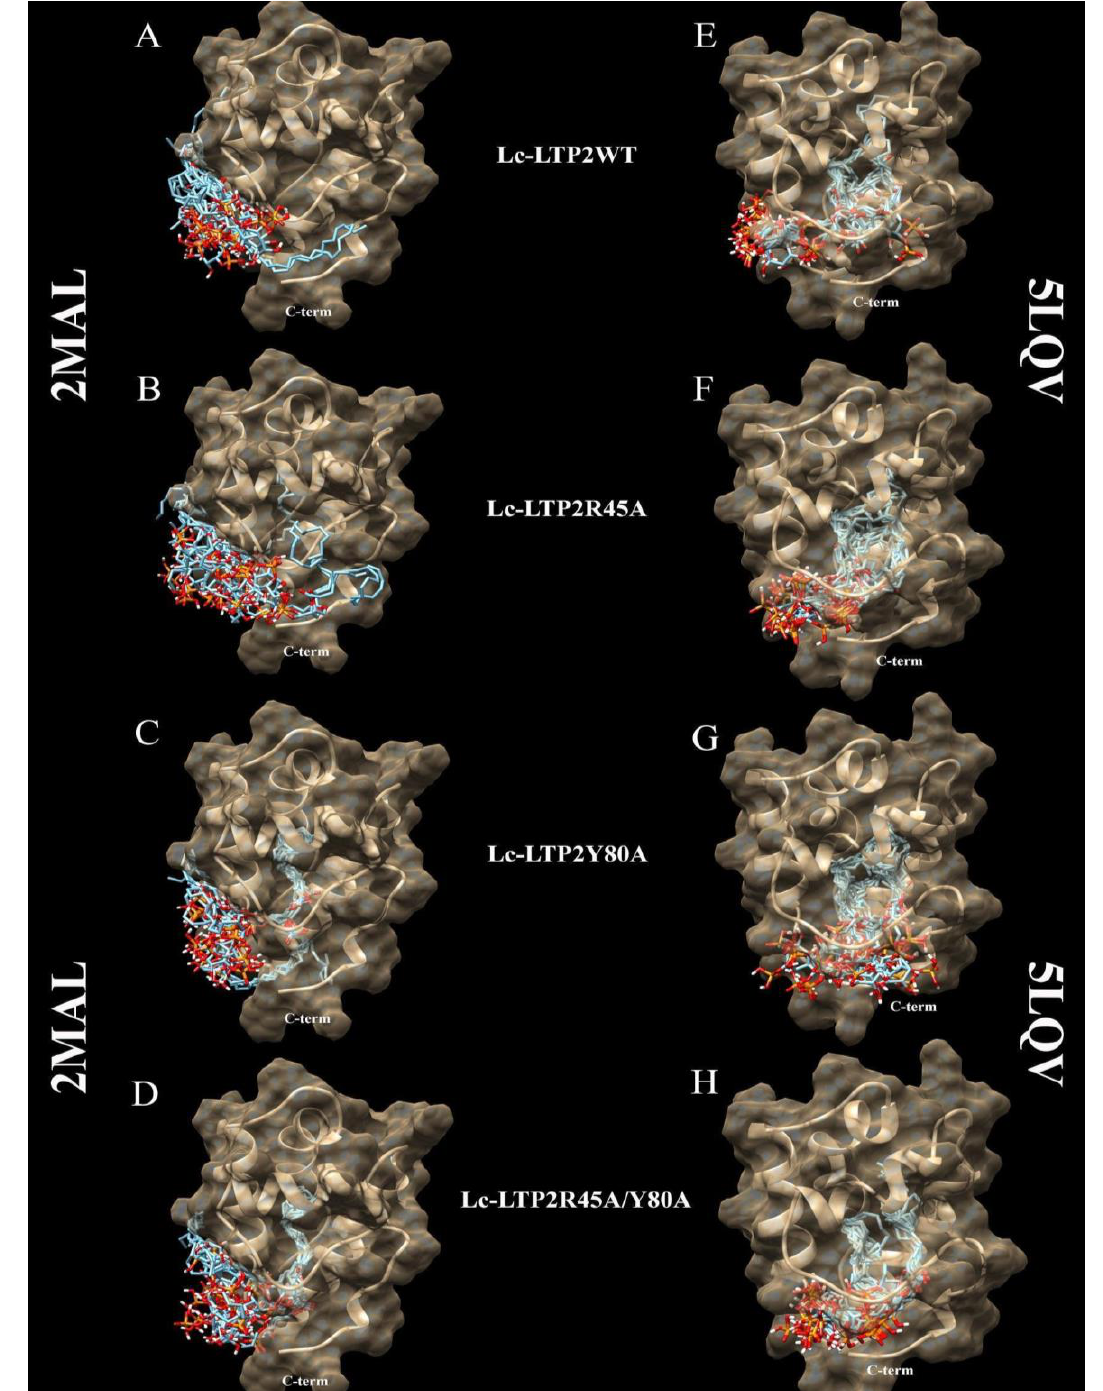
Figure 3. Spatial structures of wild-type Lc-LTP2 ( A , E ) and its mutant analogs R45A ( B , F ), Y80A ( C , G ), and R45A/Y80A ( D , H ) complexed with the PI(4,5)P2 conformations calculated by means of molecular docking. Visualization of the protein-ligand models was performed using the UCSF Chimera v.1.4 software.